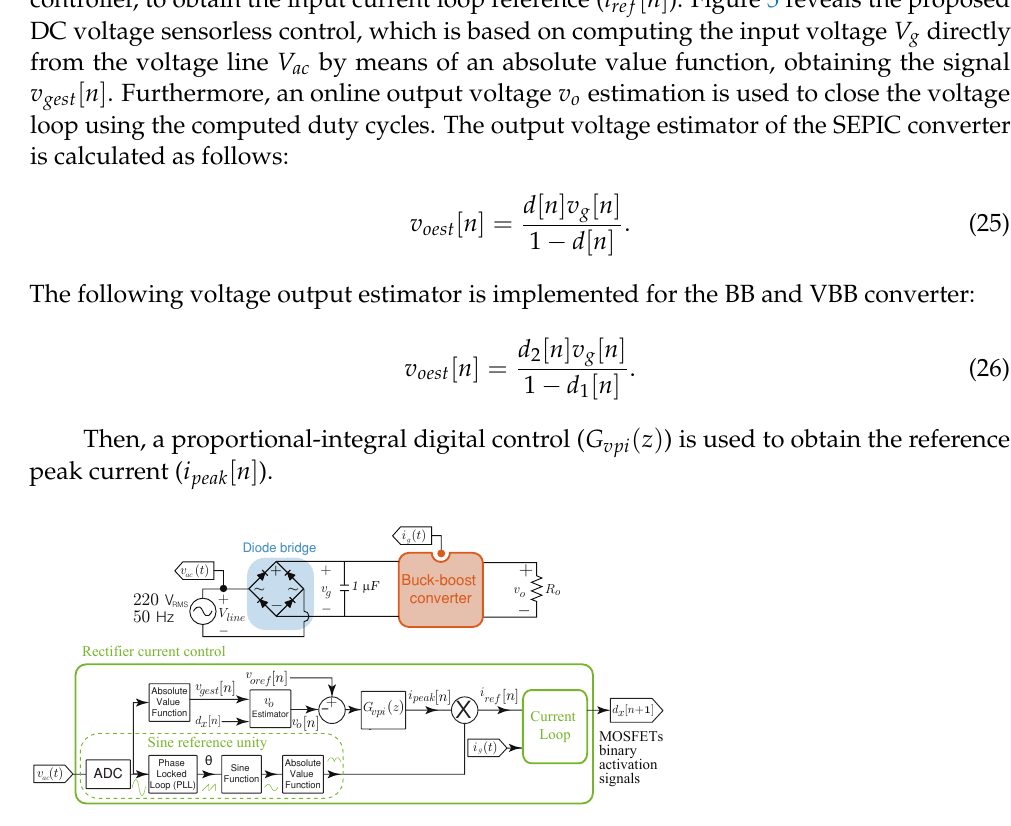
Figure 5. Block diagram of the buck-boost converter in an AC-DC application where its output voltage is